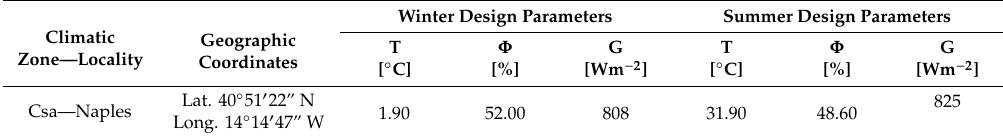
Table 2. The reference climate design parameters for the city of